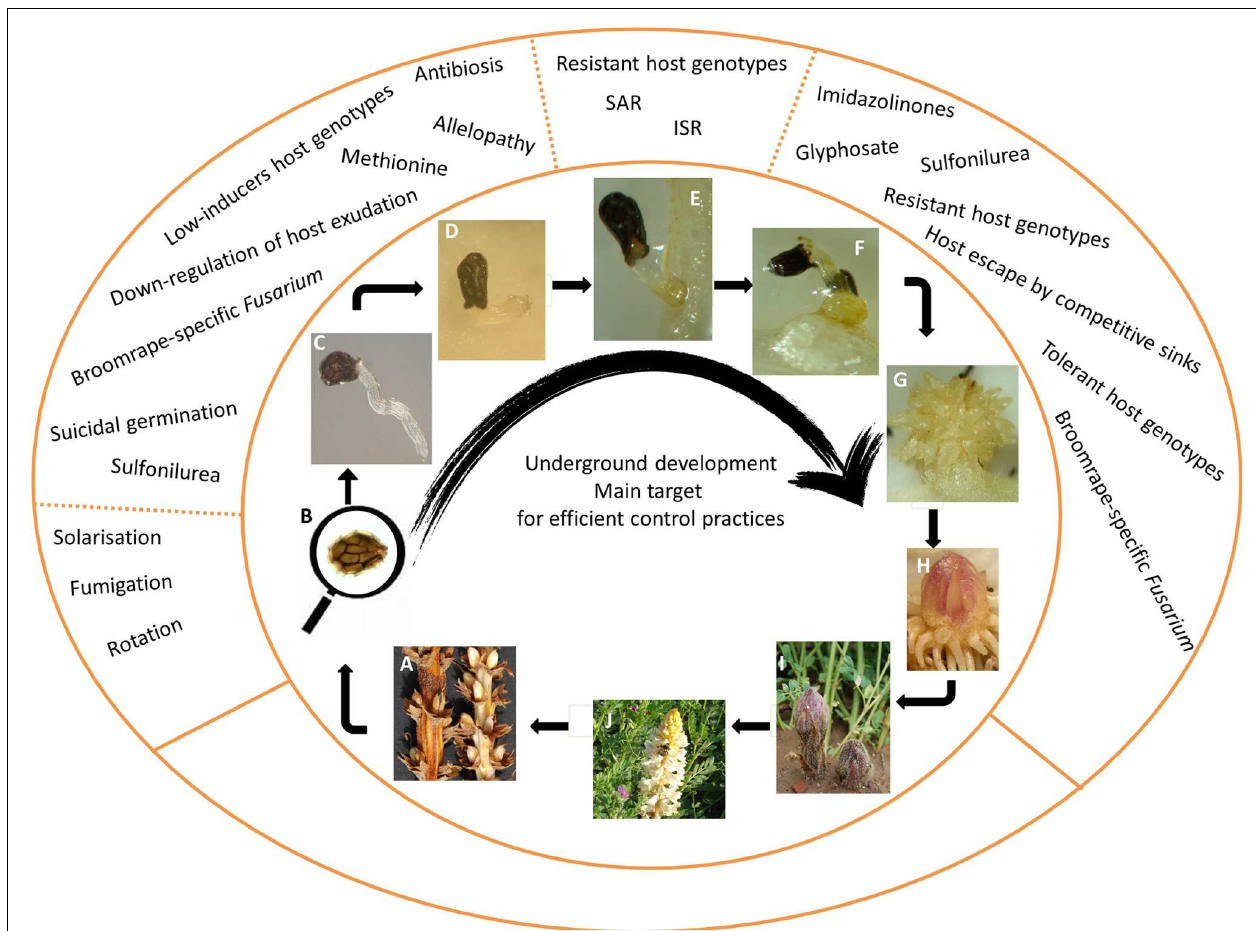
FIGURE 2 | Ilustration of broomrape life stages and mechanisms of control. (A) Fructification and dehiscence of capsules containing mature seeds; (B) microscopic view of a seed (size ranging 0.2–2 mm) that undergoes sucessive dispersal, primary dormancy and annual release of secondary dormancy; (C) broomrape embryo does not develop morphologycaly identified cotyledons or shoot meristem and upon host-induced germination, only a radicle emerges from the seed with the function of searching and contacting the host root; (D) upon haustorial induction, the radicle stops elongating and a single terminal haustorium is differentiated. The first function of haustorium is as adhesion organ to host root surface mediated by a papillae cell layer; (E) adhesion to the root 3 days after germination induction; (F) upon vascular connection with the host, broomape initiates the development of the tubercle, the broomrape storage organ for host-derived nutrients. A swelling of the host root at the penetration point is also observed due the parasitic stimulation of host tissue proliferation; (G) tubercle develops a crown of adventicious roots; (H) tubercle differentiates apical shoot meristem (single shoot meristem for Orobanche species and several shoot meristems for Phelipanche species); (I) the underground shoot eventually emerges through the root surface; (J) flowering and pollination occur. Some broomrape species are outcrossers while others are self-pollinating. Reviewed in Joel et al.